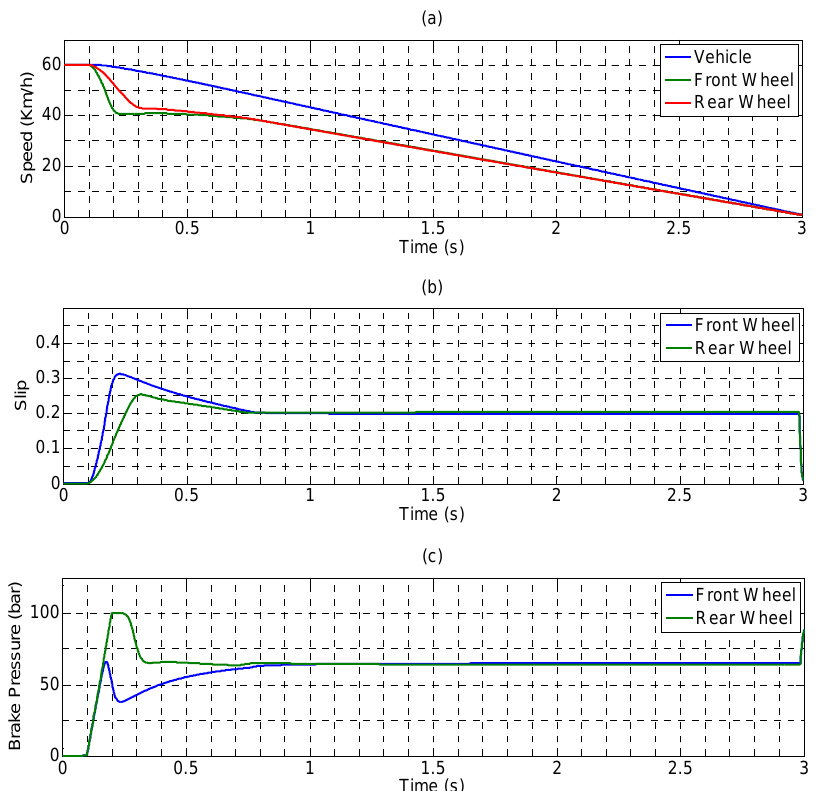
Figure 23. PEHB performing anti ‐ lock braking on a wet road surface: ( a ) vehicle speed and wheel speed; ( b ) slip; and ( c ) brake pressure.